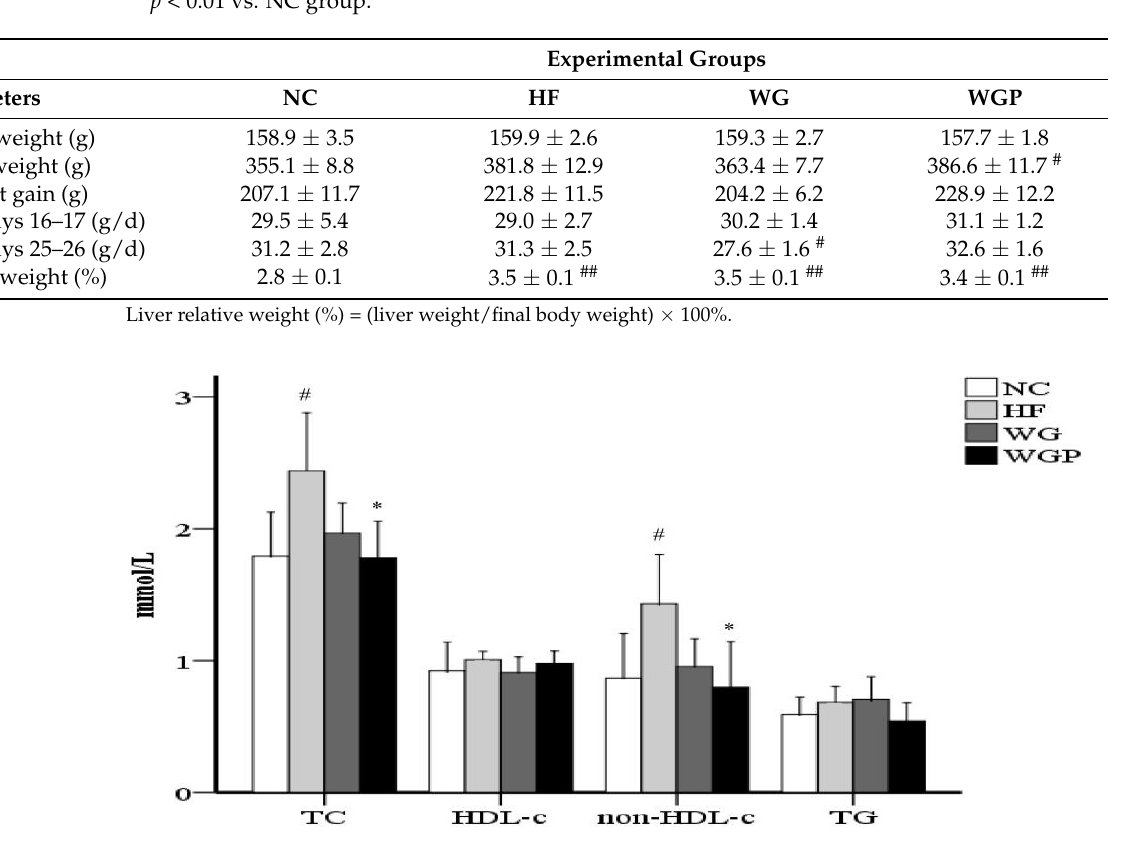
Table 1. Effect of wheat germ and wheat germ protein on body weight, liver weight and food intake in high-fat diet-induced rats. Values are presented as means ± SEMs ( n = 5). # p < 0.05, ## p < 0.01 vs. NC group.